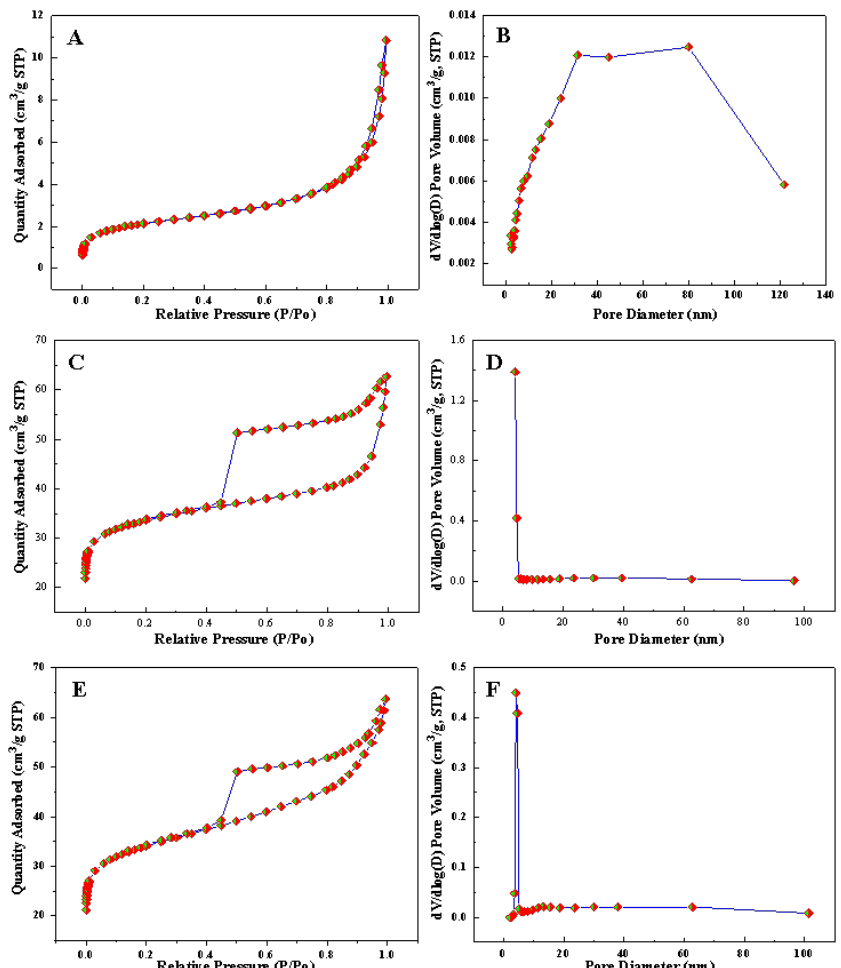
Figure 6. BET curve and pore size distribution curve of Fe 3 O 4 @RF-12 ( A , B ), Fe 3 O 4 @C-700 ( C , D ) and Fe@C-12 ( E , F ).